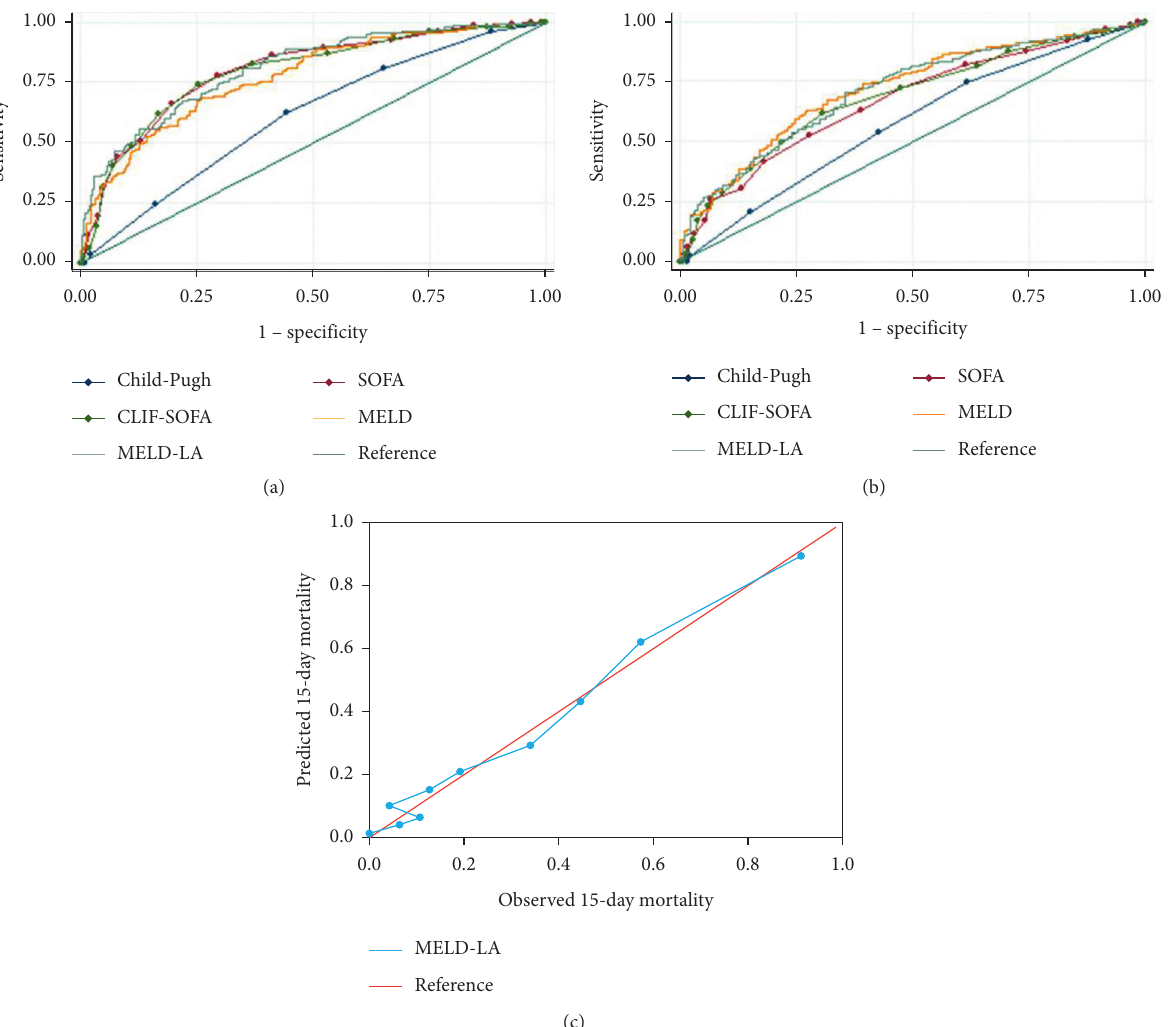
Figure 1: Receiver operating characteristic curves of the scoring systems for (a) 15-day and (b) 5-year mortality and (c) calibration curve of the MELD-LA score for 15-day mortality in the whole study population. SOFA, sequential organ failure assessment; CLIF-SOFA, chronic liver failure-sequential organ failure assessment; MELD, model for end-stage liver disease; MELD-LA, model for end-stage liver disease-